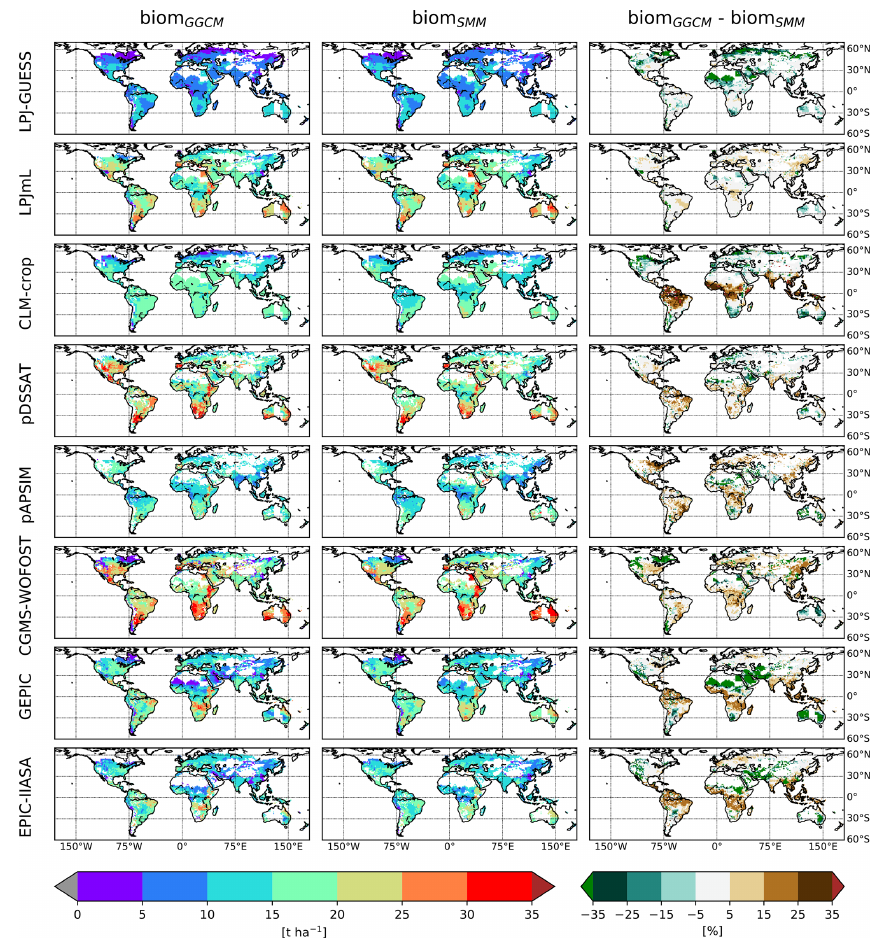
Figure 4. Comparison of the spatial distribution of simulated aboveground biomass (biom) between GGCM and SMM after its calibration. For each GGCM (row), the following variables are displayed: biom GGCM (left column), biom SMM after SMM calibration (i.e., calibration of global GGCM-dependent C and RUE and spatially varying GDD 1leaf ), and the difference between the two (biom GGCM − biom SMM ) (expressed in percent of biom GGCM ). Only biom SMM after SMM calibration with the first ( C , RUE) pair is